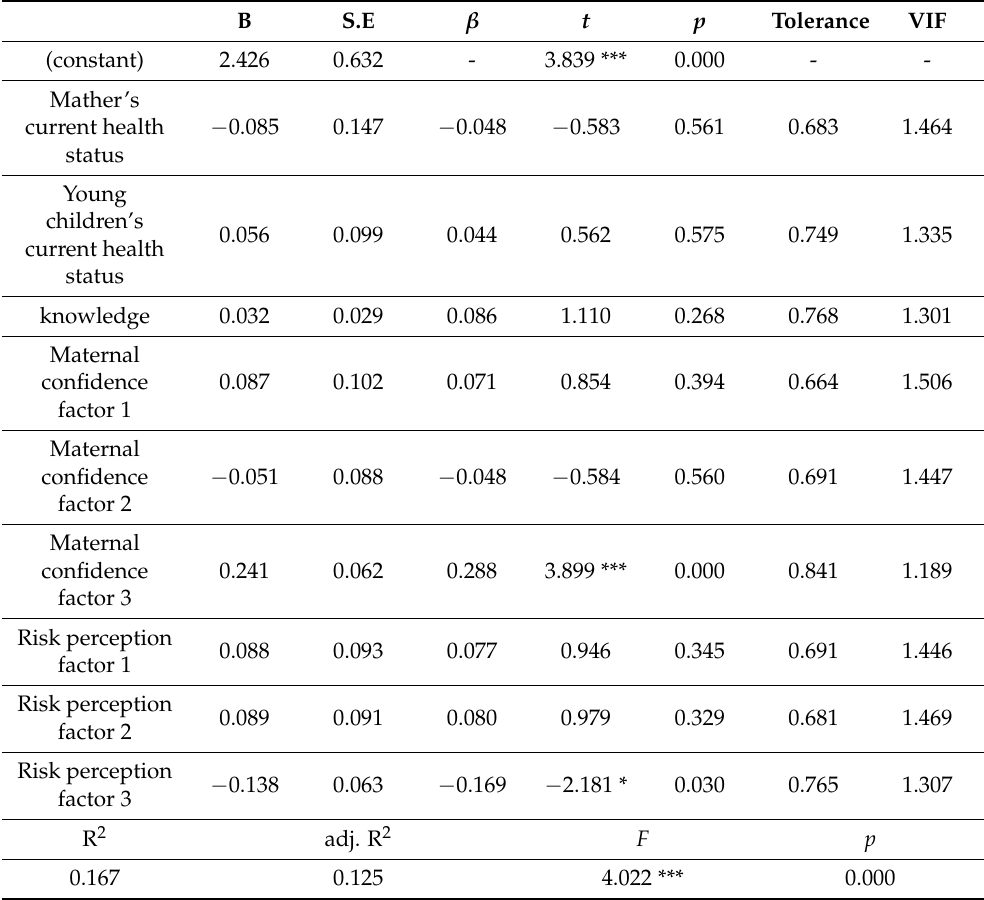
Table 4. Effect of COVID-19 knowledge, maternal confidence, and risk perception on Preventive health behaviors of COVID-19 factor